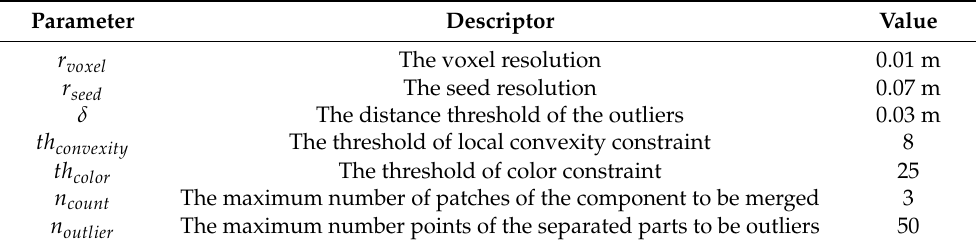
Table 2. Parameter settings of MCGC